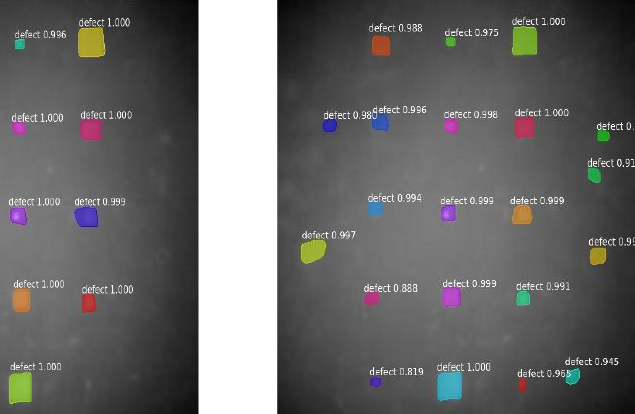
Figure 8. The best obtained validation results of Mask-RCNN segmentation on different training databases. From left to right: original images, training on the preprocessed raw images database, training on the mixed database (preprocessed data from synthetic and raw images). From the first three rows to the last two rows: plexiglass ( a – c ), carbon fiber-reinforced polymer (CFRP) ( d – e ).